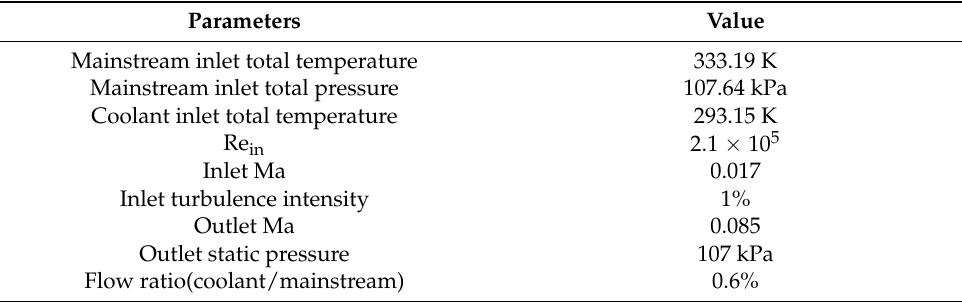
Table 2. Computational boundary